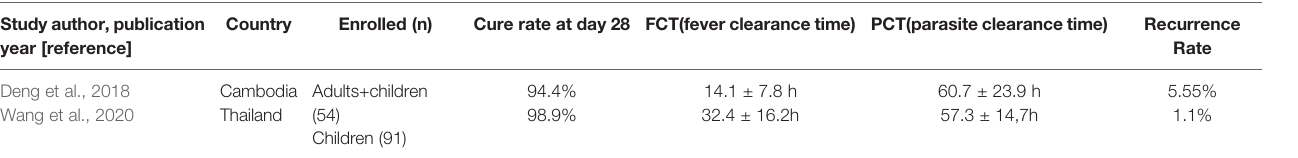
TABLE 1 | Characteristics of the single-arm studies.